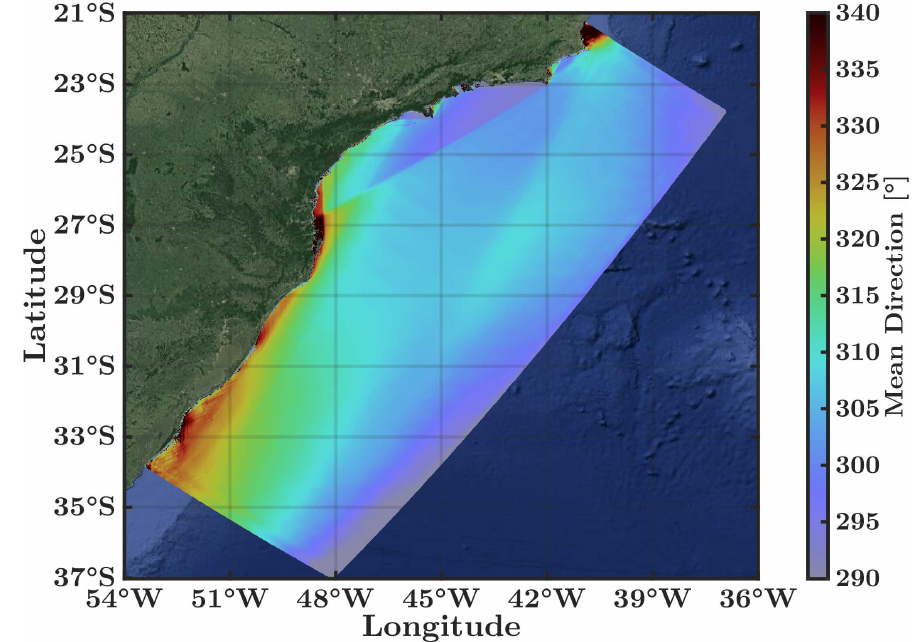
Figure 6. Mean value of mean direction D m (°) over 18